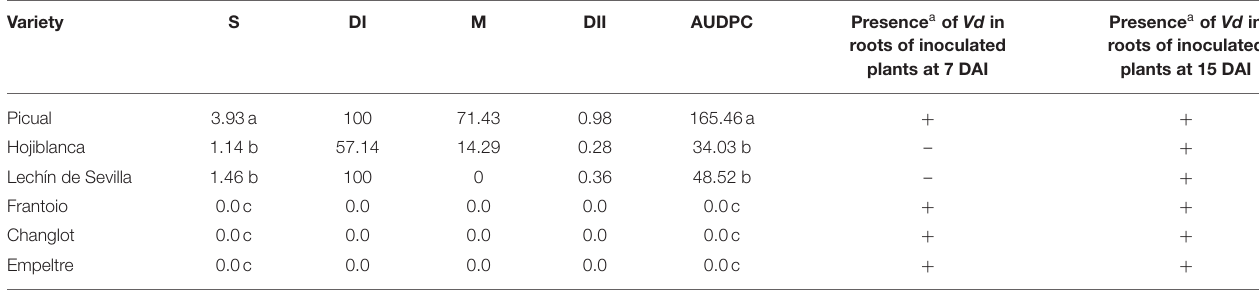
TABLE 2 | Verticillium wilt of olive parameters scored for the six olive varieties under study.